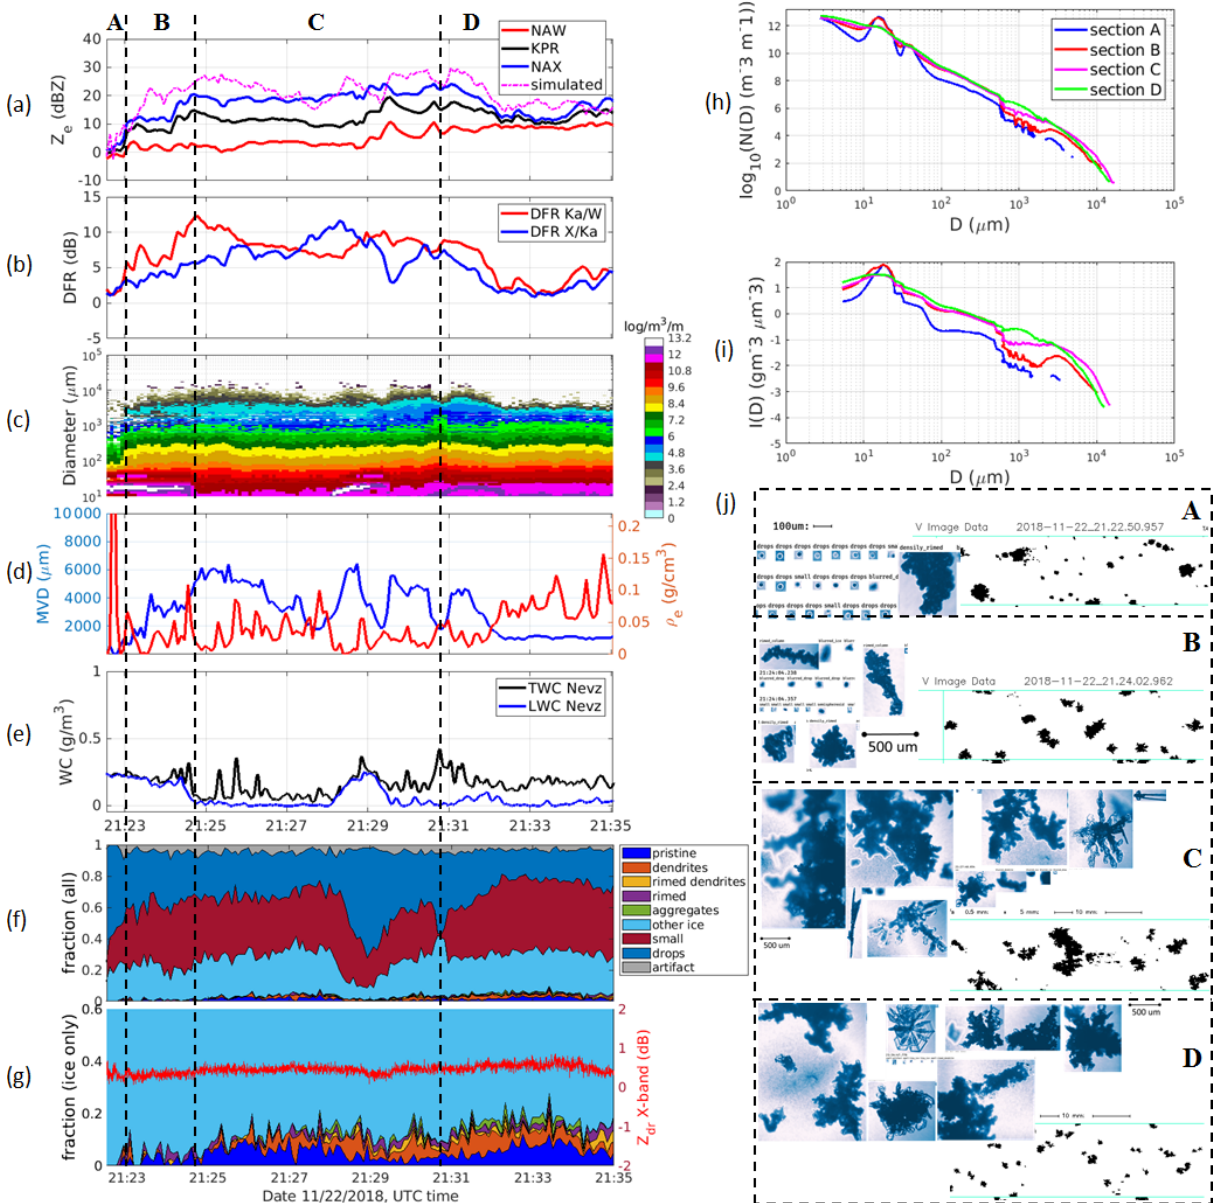
Figure 14. Similar to Fig. 12 but for segment